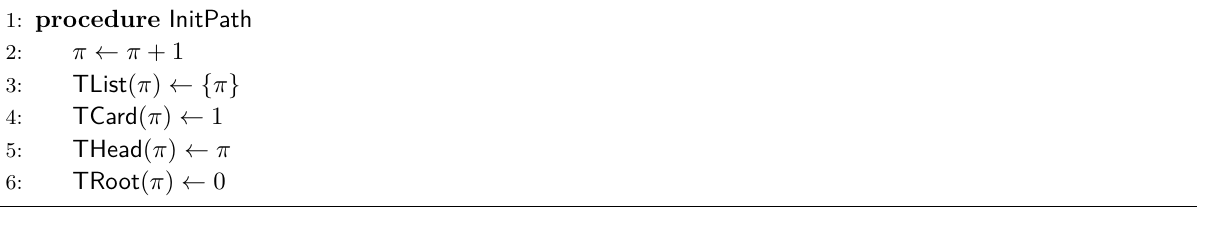
Algorithm 5 The algorithm that deletes non-relevant paths.